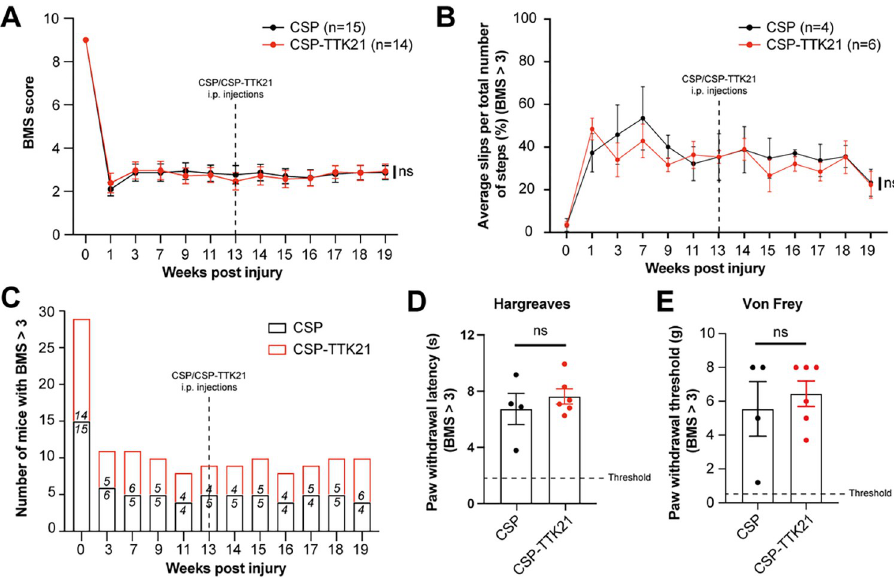
Fig 4. Sensorimotor behavioural tests after CSP-TTK21 treatment in chronic SCI with severe disability. (A) BMS quantification of CSP ( n = 15) or CSP-TTK21 ( n = 14) treated mice after chronic SCI (Treatment: f(1) = 0.002, p = 0.96 (TOST: given equivalence bounds of − 0.21 and 0.21, 90% confidence intervals fall − 0.37 and 0.32 and p = 0.307, thus H0 is undecided); Time: f(12) = 192.1, p < 0.001 (TOST: given equivalence bounds of − 0.21 and 0.21, 90% confidence intervals fall − 0.24 and − 0.15 and p = 0.215, thus H0 is rejected); Interaction (treatment × time): f(12) = 6.6, p = 0.82 (TOST: given equivalence bounds of − 0.21 and 0.21, 90% confidence intervals fall 4.19 and 4.99 and p > 0.999, thus H0 is rejected). Two-way repeated measures ANOVA with Sidak post hoc test. ( B ) Gridwalk quantification of the percentage of slips per total number of steps per run in CSP ( n = 4) or CSP-TTK21 ( n = 6) treated mice with a BMS score greater than 3 after chronic SCI (Treatment: f(1) = 0.2, p = 0.69 (TOST: given equivalence bounds of − 1.78 and 1.78, 90% confidence intervals fall − 7.96 and 2.63 and p = 0.693, thus H0 is undecided); Time: f(12) = 7.1, p < 0.001 (TOST: given equivalence bounds of − 1.78 and 1.78, 90% confidence intervals fall − 0.73 and 0.66 and p < 0.001, thus H0 is accepted); Interaction (treatment × time): f(12) = 6.6, p = 0.82 (TOST: given equivalence bounds of − 1.78 and 1.78, 90% confidence intervals fall − 28.59 and 41.29 and p > 0.999, thus H0 is rejected). Two-way repeated measures ANOVA with Sidak post hoc test). ( C) Bar graph indicating the number of mice with a BMS score greater than 3 across postinjury time points. ( D) Hargreaves test indicating average paw withdrawal latency in CSP or CSP-TTK21 (Welch two-tailed t test: CSP: 6.7 ± 1.1, n = 4; CSP-TTK21: 7.6 ± 0.5, n = 6, p = 0.51, TOST: t(8) = − 0.3, p = 0.63 given equivalence bounds of − 0.5 and 0.5 on a raw scale and an alpha of 0.05) treated mice with a BMS score greater than 3. ( E) Von Frey test indicating average paw withdrawal threshold in CSP or CSP-TTK21 (Welch two-tailed t test: CSP: 5.5 ± 1.6, n = 4; CSP-TTK21: 6.4 ± 0.7, n = 6, p = 0.64, TOST: t(4.3) = − 0.1, p = 0.52 given equivalence bounds of − 0.8 and 0.8 on a raw scale and an alpha of 0.05) treated mice with a BMS score greater than 3. All data are given